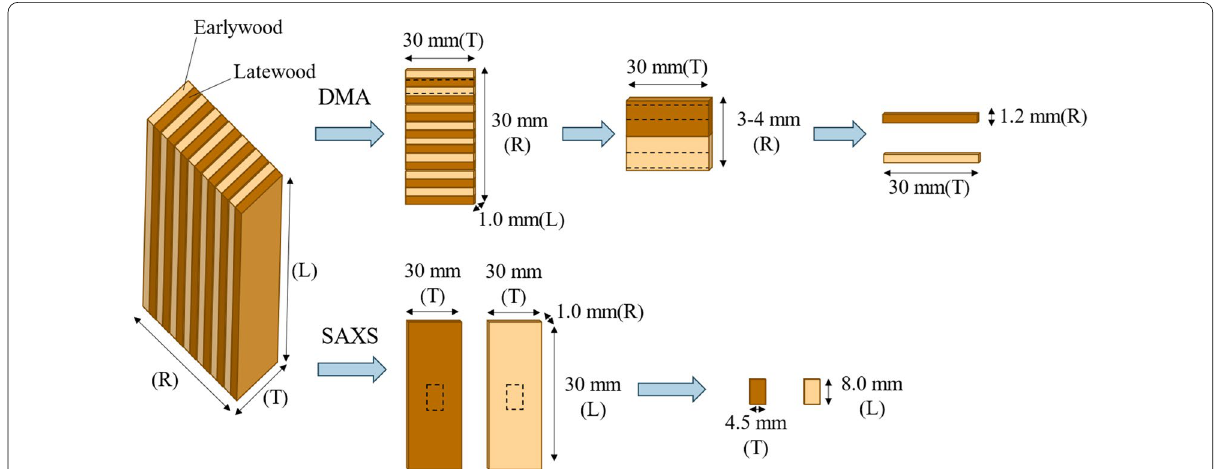
Fig. 1 The schematic diagram of sample shape of dynamic mechanical analysis (DMA) and small angle X-ray scattering